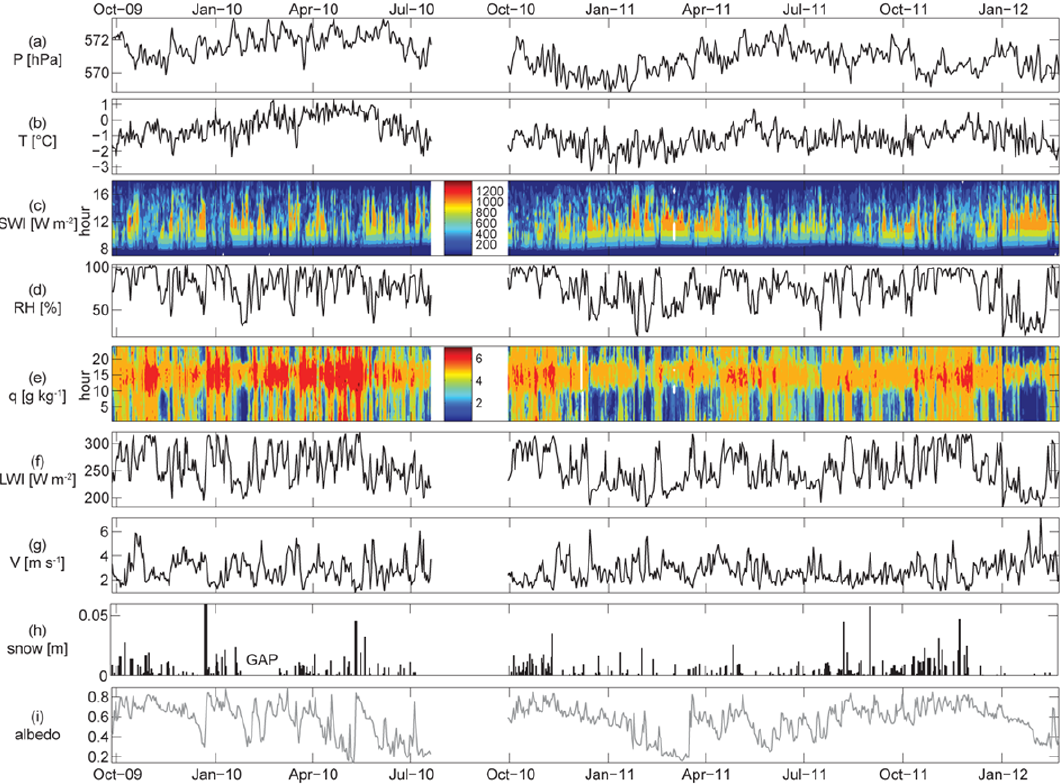
Fig. 2. Summary of daily mean meteorological conditions measured at Lewis Glacier AWS (4828m Mt Kenya). Incoming shortwave radiation and specific humidity are shown as isopleth diagrams to highlight the evident afternoon development of cloud cover and peak specific